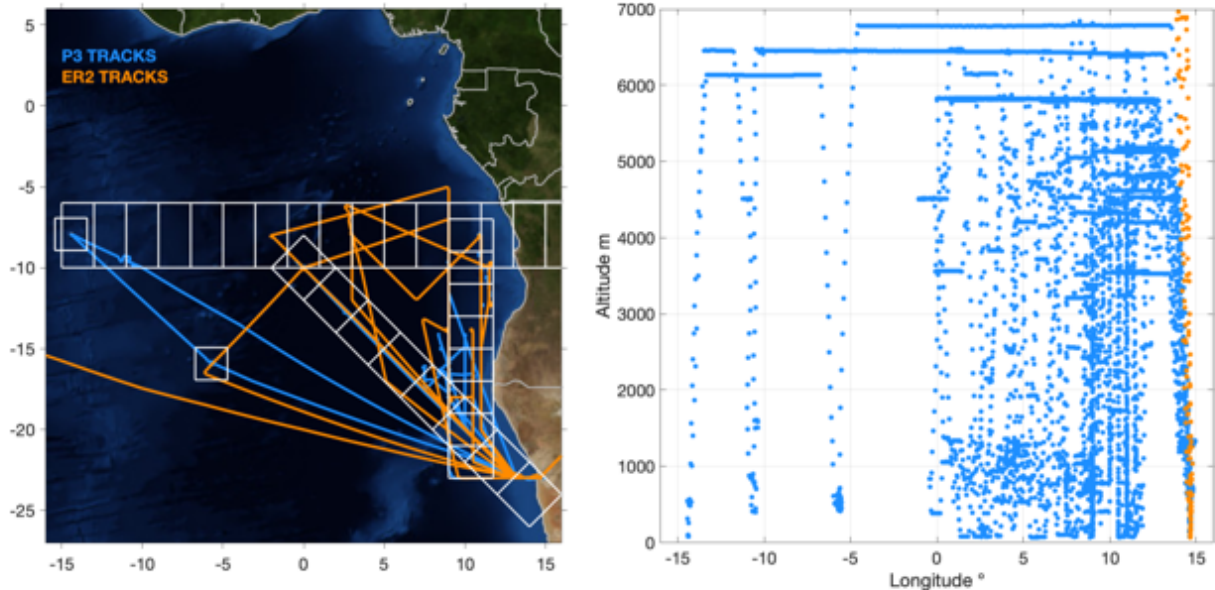
Figure 3. Left: the boxes selected for the model–observation comparison, overlaid on the P3 and ER2 flight paths (with HSRL-2 observations) from September 2016 and NASA’s Blue Marble: Next Generation surface image, courtesy of NASA’s Earth Observatory. Right: the altitude and longitude of the flights averaged over 60s. The ER2 was at altitude of about 20km except for take-off and